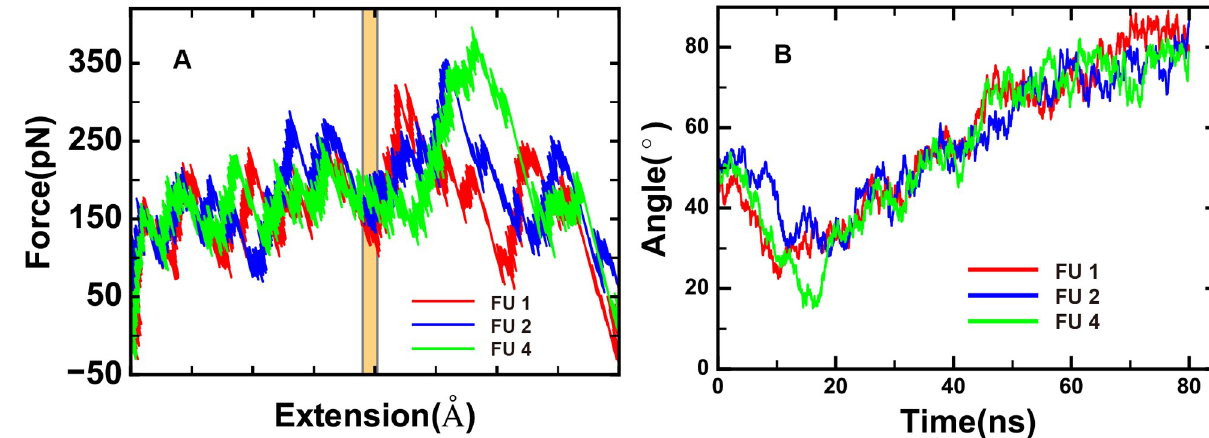
Fig 6. Analysis of SMD simulations. (A)Force-extensioncurves of SMD simulations FU1, FU2 and FU4. The yellow, shaded area represents zero layer position. (B)The changeof the SNARE orientationwith the membraneduringthe simulations.